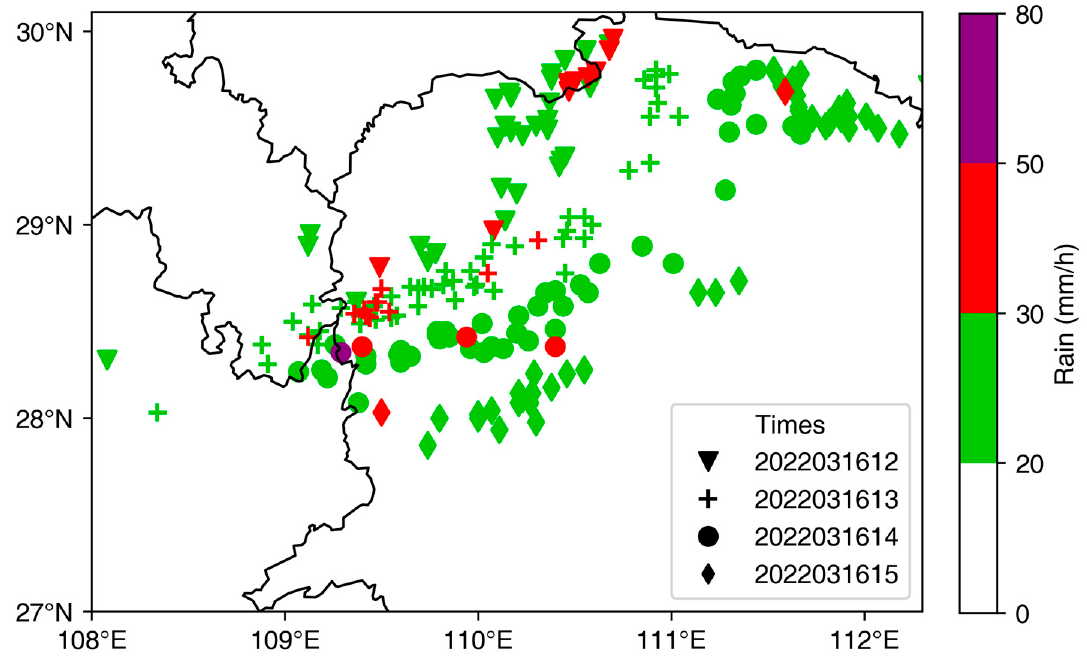
line. The time values are given in the legend.